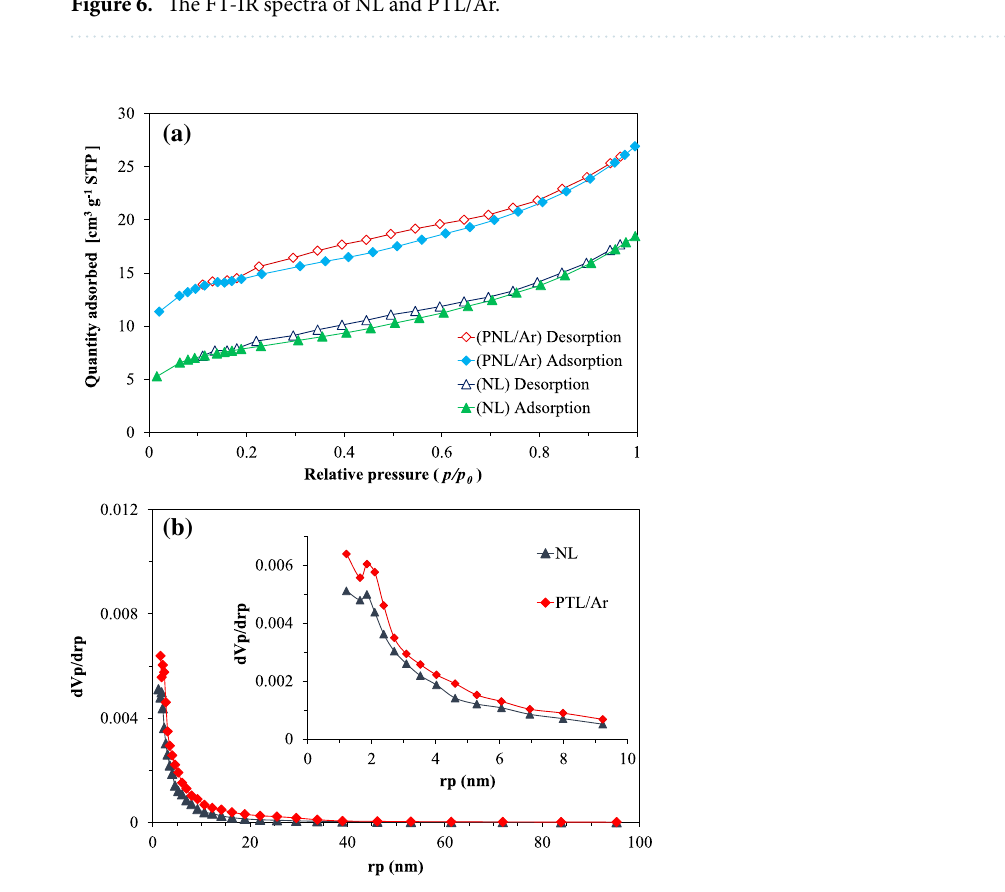
Figure 6. The FT-IR spectra of NL and PTL/Ar.